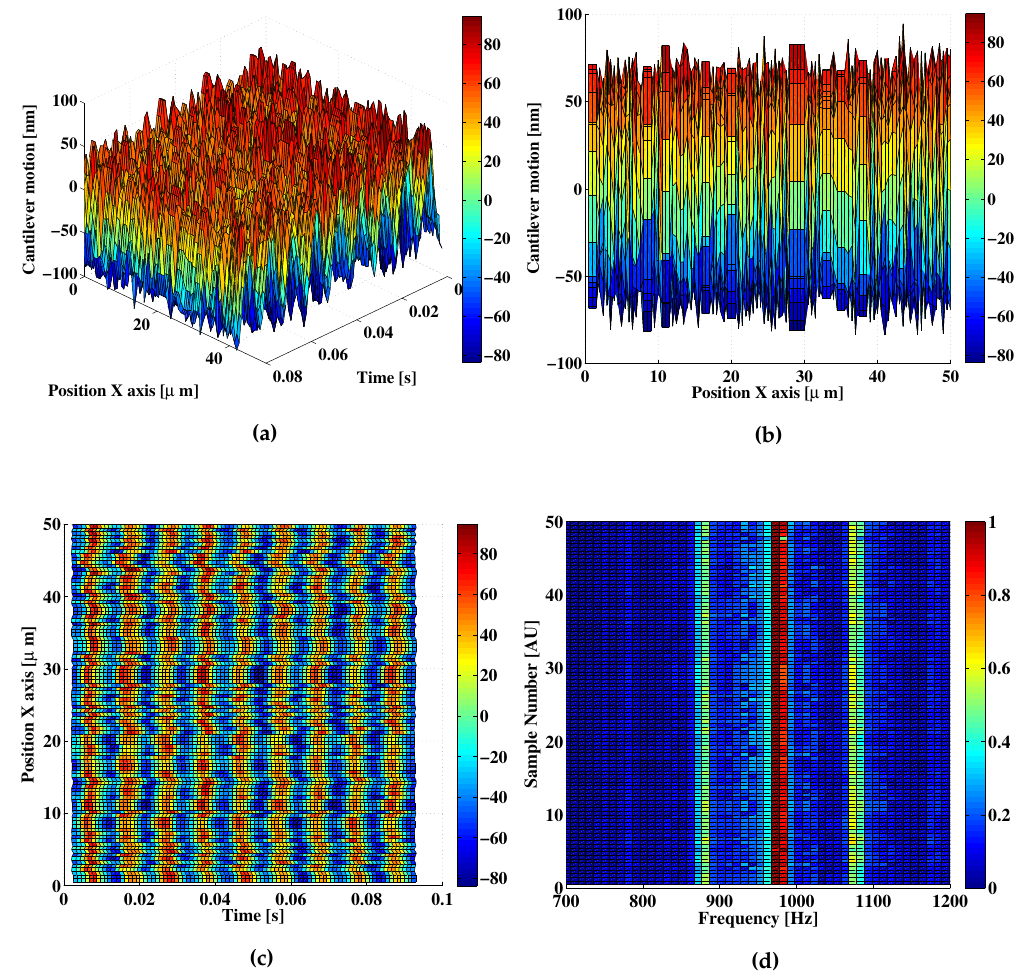
Figure 12. Example of an experimental A = 100-nm cantilever displacement reconstruction under low acoustic noise conditions. The displacement is shown in different projections: ( a ) 3D; ( b ) Top and ( c ) Lateral view; ( d ) Top view of the Fourier spectra around the main harmonic of the OFI measurement signal for each of the points acquired in the